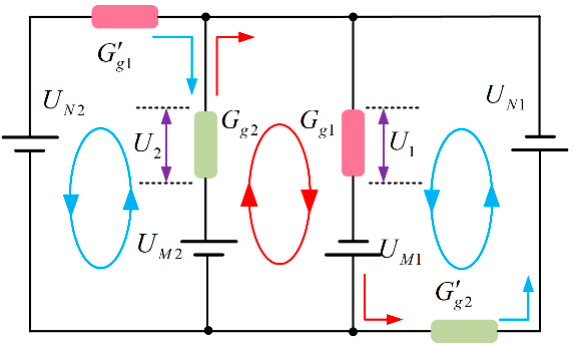
Figure 14. Equivalent Magnetic Circuit Model of Electromagnetic Torque.